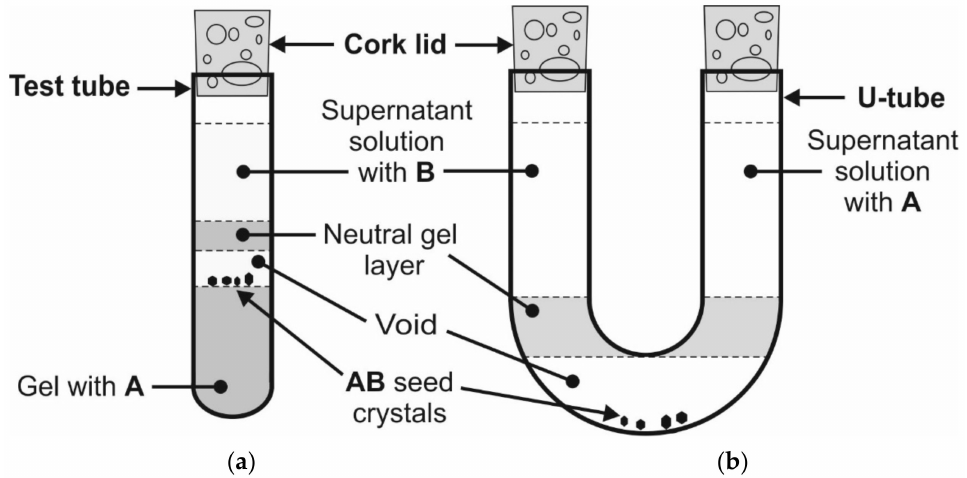
Figure 15. Hybrid gel setups: ( a ) Single-diffusion variant [43]; ( b ) Double-diffusion variant. The void initially contains the heavy NH 4 NO 3 or (NH 4 ) 2 SO 4